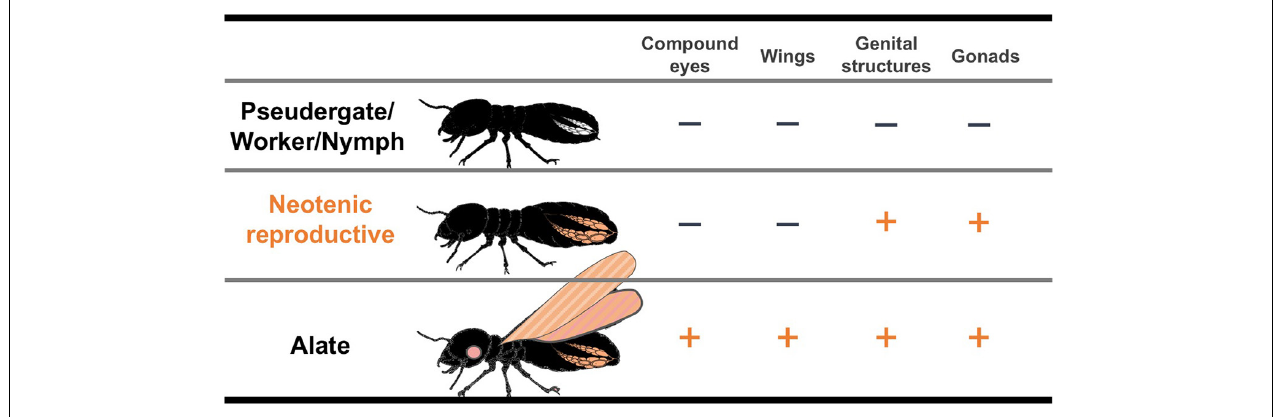
FIGURE 2 | Schematic illustrations of the developmental degree of imaginal organs in each caste. “+” indicates well-developed imaginal organs like alates. “–” indicates imaginal organs with suppressed or interrupted developments compared with those of